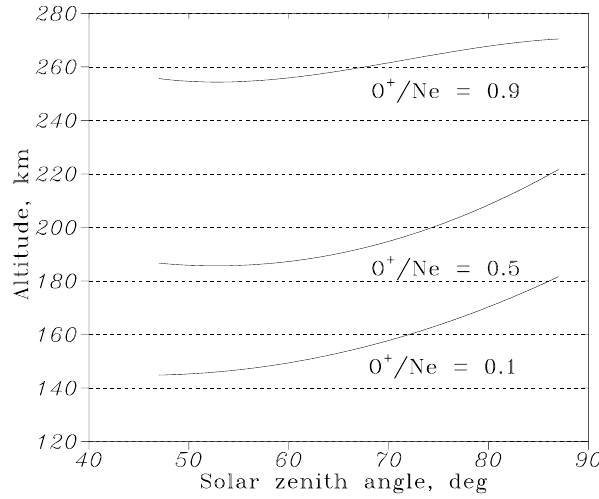
Fig. 4. Calculated height profiles of the O + /Ne ratio at three so- lar zenith angles. The standard EISCAT ion composition model is shown for a comparison (dashes).